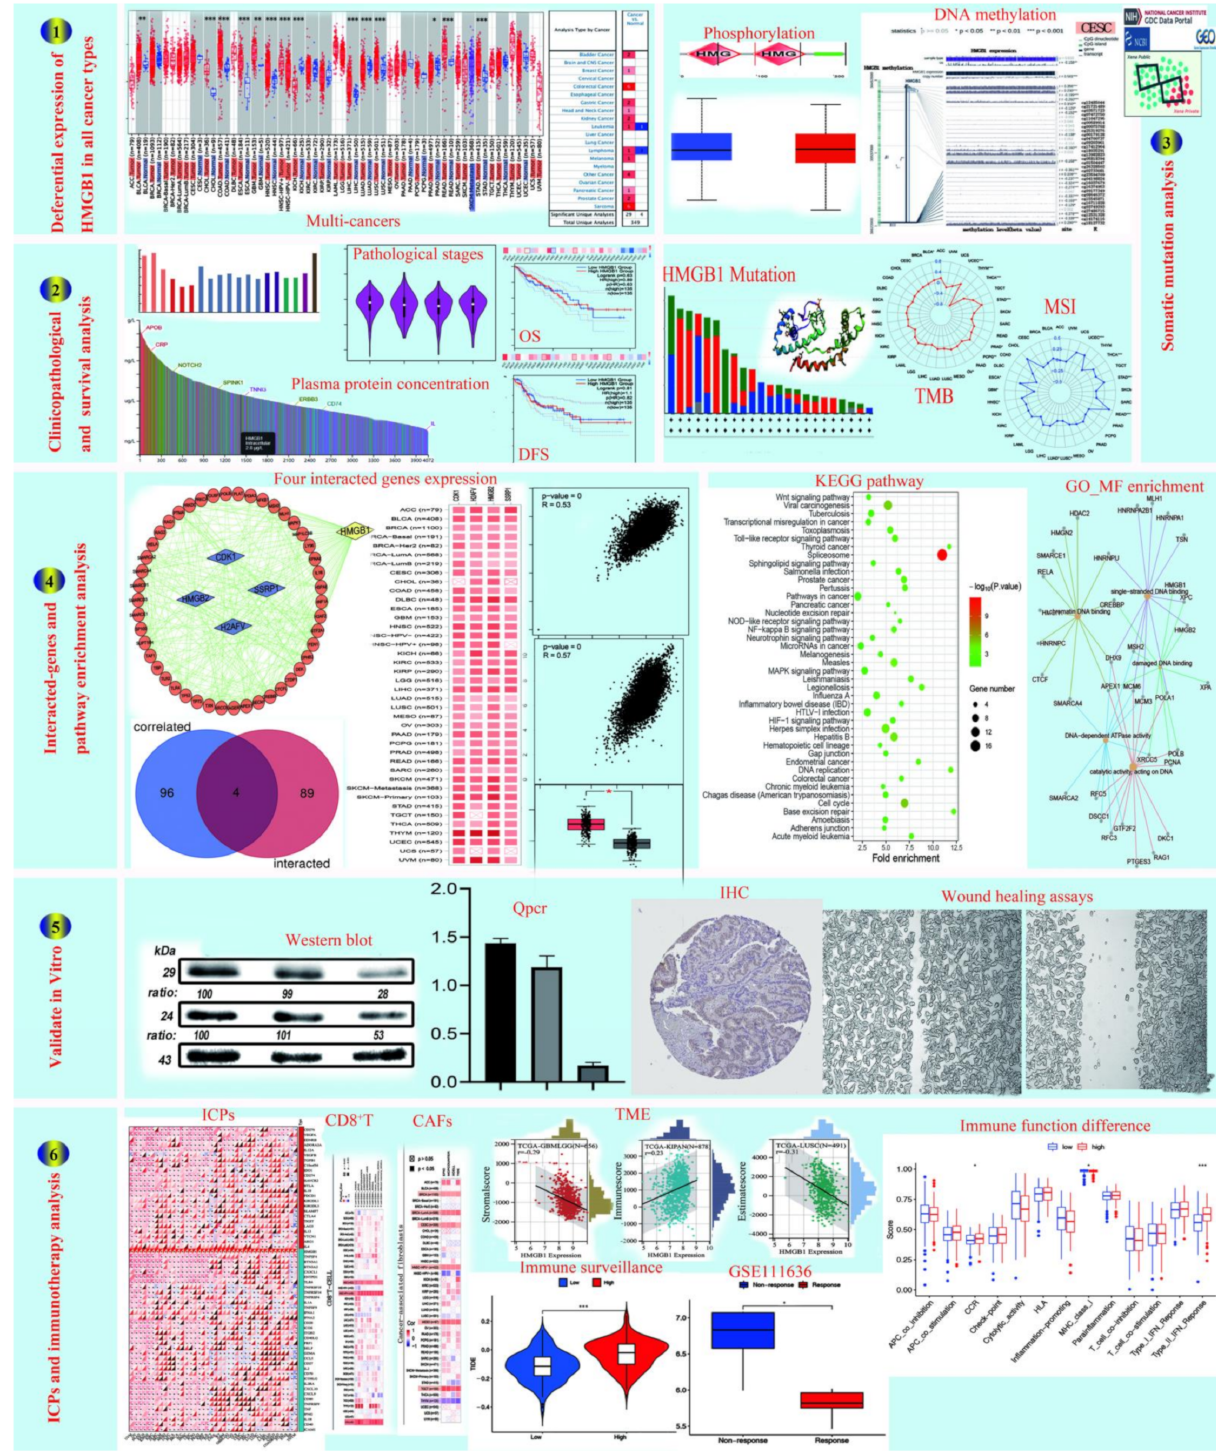
Figure 1. Flow chart of the HMGB1-related study design and analysis. ( 1 ) Differential expression of HMGB1 in all cancer types. ( 2 ) Clinicopathological and survival. ( 3 ) Somatic mutation anal- ysis. ( 4 ) Interacted-genes and pathway enrichment analysis. ( 5 ) Validate in vitro. ( 6 ) ICPs and immunotherapy analysis. * Statistically significant p -value calculated (Pearson correlation analysis) p < 0.05, ** p < 0.01, *** p <